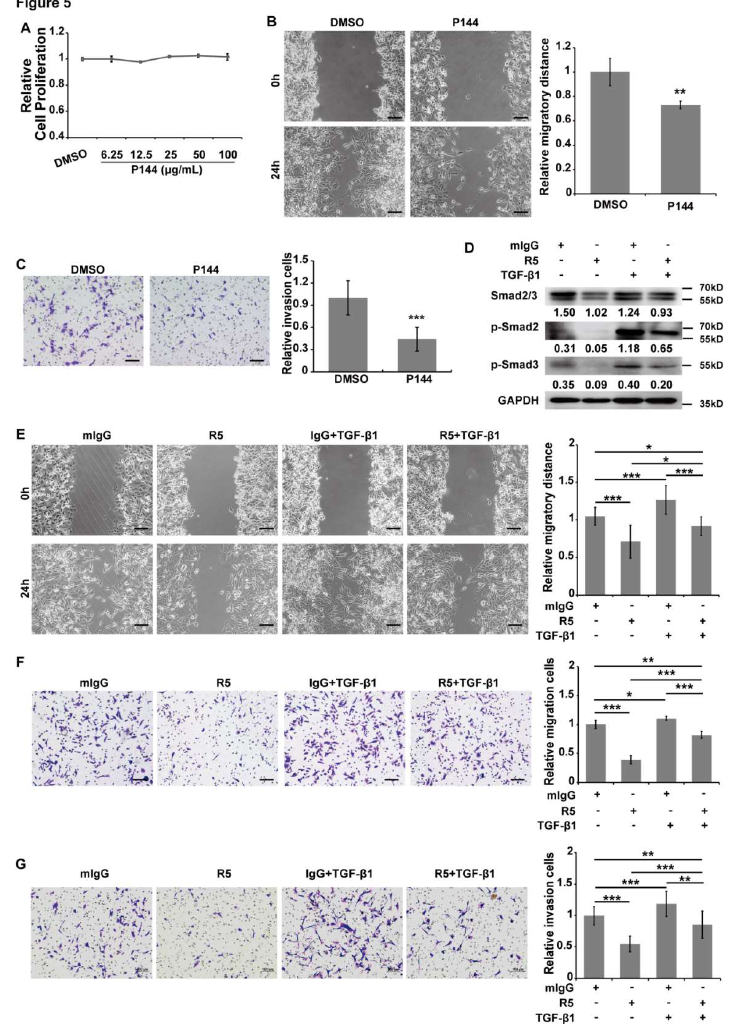
Figure 5. Blocking of Slit2 / Robo1 signaling inhibits cell migration, chemotactic, and invasion ability, which is partially dependent on the TGF- β 1 / Smad2 / 3 pathway. ( A ) There was no significant di ff erence in the cell proliferation of Lovo cells between the cells that were treated and those that were not treated with P144, a specific TGF- β 1 inhibitor, for 48 h. Lovo cells were treated with DMSO (Dimethyl sulfoxide) or P144 and the cell migration ( B ) and invasion ( C ) abilities were detected. P144 significantly inhibits the migration and invasion ability of Lovo cells. ( D ) The inhibition of smad2 and smad3 phosphorylation by R5 was abolished by TGF- β 1 treatment that was detected by the Western blotting assay. A wound healing assay ( E ), Transwell migration assay ( F ), and Matrigel invasion assay ( G ) were employed to detect whether the TGF- β 1 pathway is involved in Slit2 / Robo1 signaling-mediated cell migration and invasion. Lovo cells were treated with R5 or TGF- β 1, or treated with both R5 and TGF- β 1, to further detect cell migration, chemotactic, and invasion abilities. R5 suppressed cell migration, chemotactic, and invasion ability in Lovo cells. Inversely, treatment with TGF- β 1 increased migration, chemotactic, and invasion ability in Lovo cells. Further treatment with R5 and TGF- β 1 could partially reverse the inhibitory e ffi cacy of R5 on cell migration, chemotactic, and invasion ability. *: p < 0.05, **: p < 0.01, and ***: p < 0.001. The protein bands were quantified densitometrically and normalized to GAPDH expression. Scale Bars: 100 µ